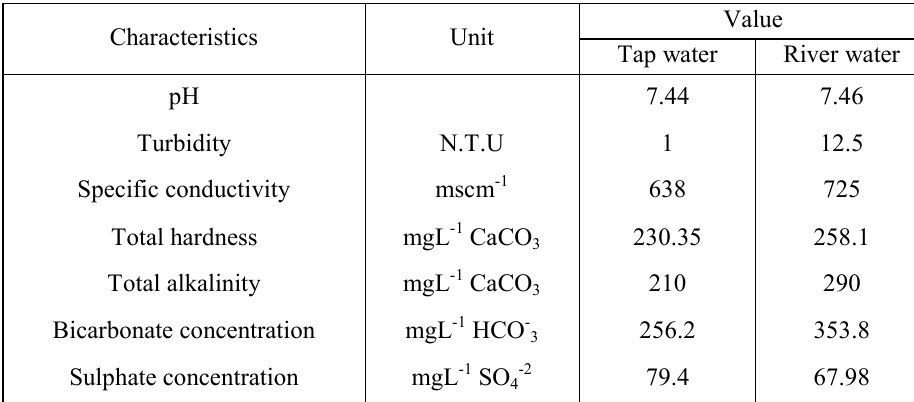
Table 1 . Characteristics of real water.